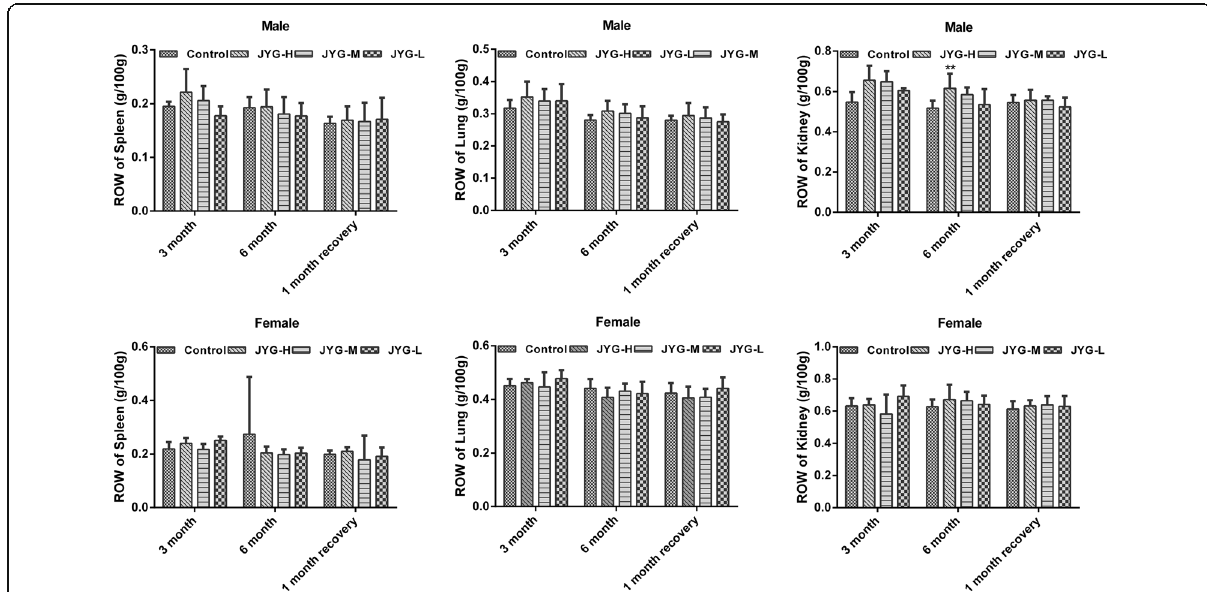
Fig. 7 Relative organs of spleen, lung, and kidney in the control and JYG-treated groups in the chronic toxicity test. Note: ROW: relative organs weight;